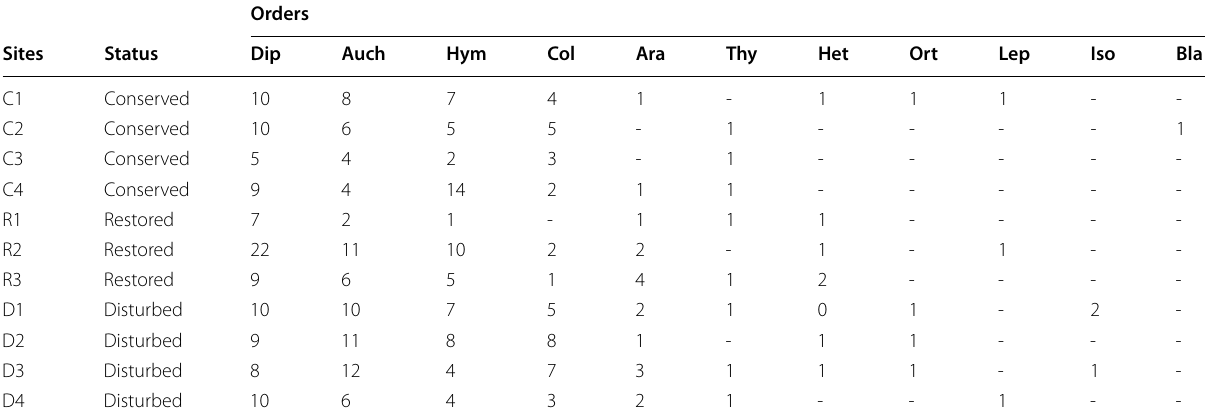
Dip Diptera, Auch Auchenorryncha, Hym Hymenoptera, Col Coleoptera, Ara Arachnida, Thy Thysanoptera, Het Heteroptera, Ort Orthoptera, Lep Lepidoptera, Iso Isopoda, Bla Blattodea